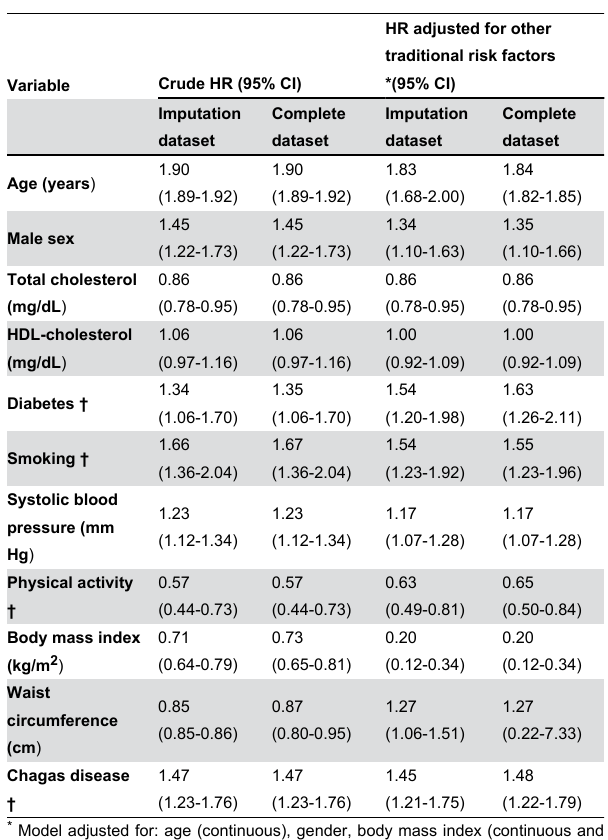
Table 2. Crude and adjusted hazard ratios (HR) per standard deviation change and 95% confidence interval (CI) of death in the model with traditional risk factors